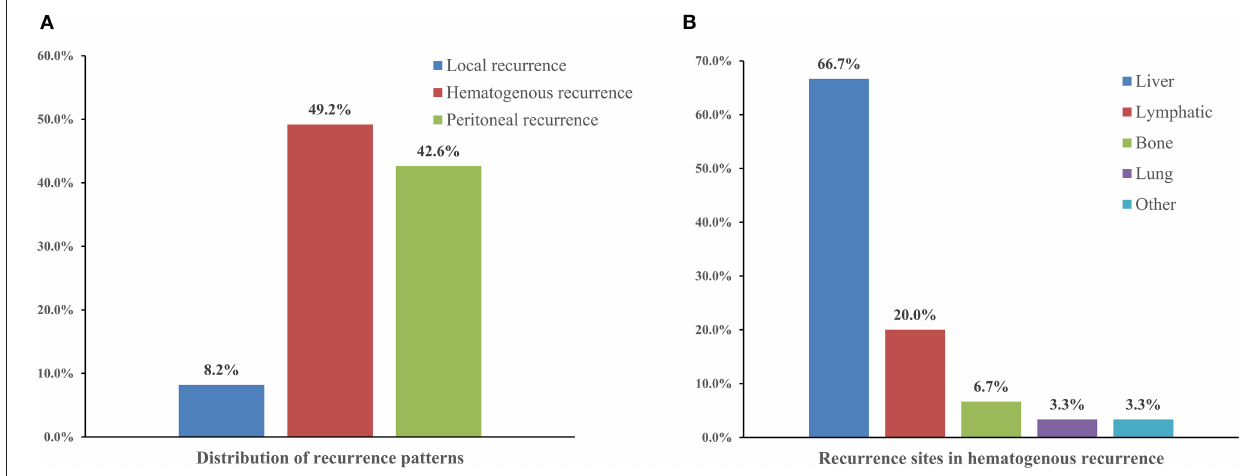
FIGURE 1 | The distribution of recurrence patterns (A) and recurrence sites in hematogenous recurrence (B) in gastric cancer patients with recurrence.